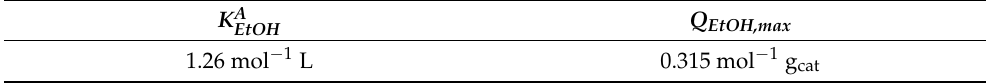
Table 1. Adsorption Constants for Ethanol when Using the 0.25 wt% Pd-TiO 2